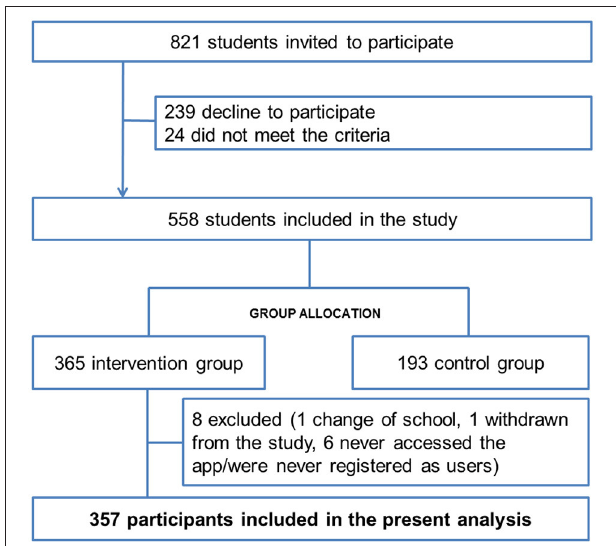
FIGURE 1 | Study sample